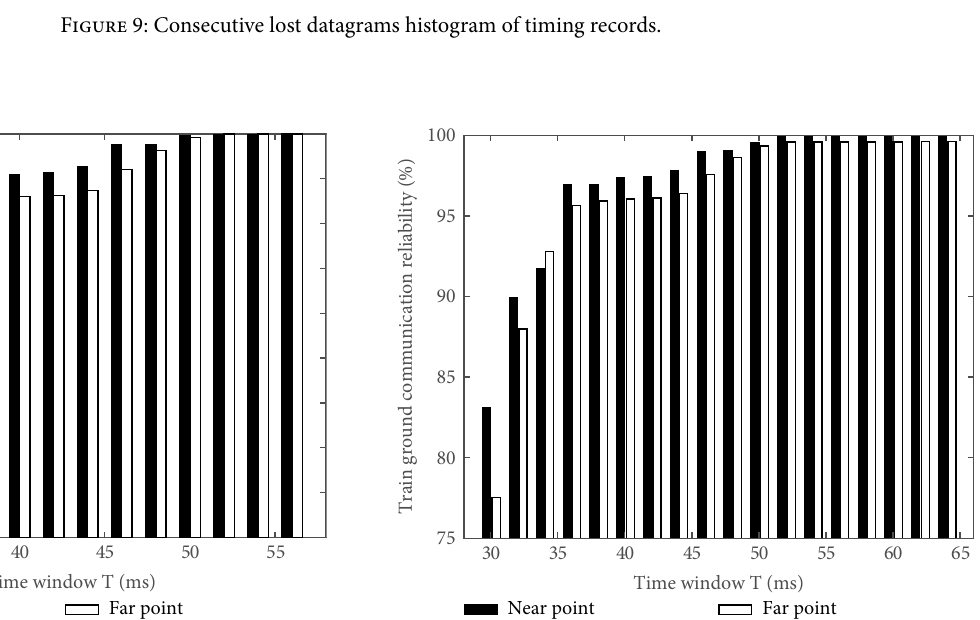
Figure 12: Reliability of train ground communication